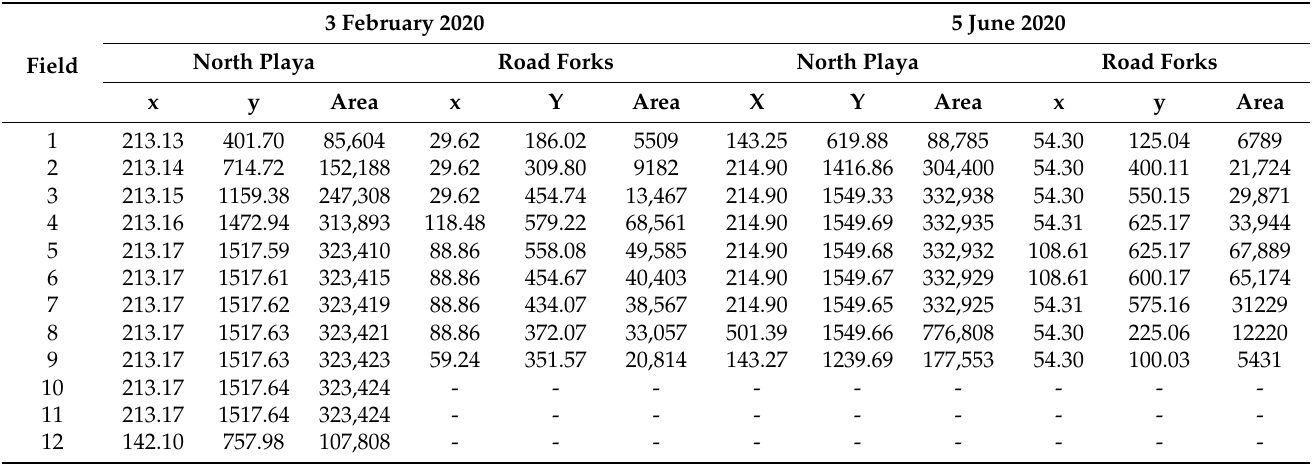
Table 1. Dimensions of each axis of the rectangular subfields shown in Figure 3. Axis lengths x and y in meters, and area in m 2